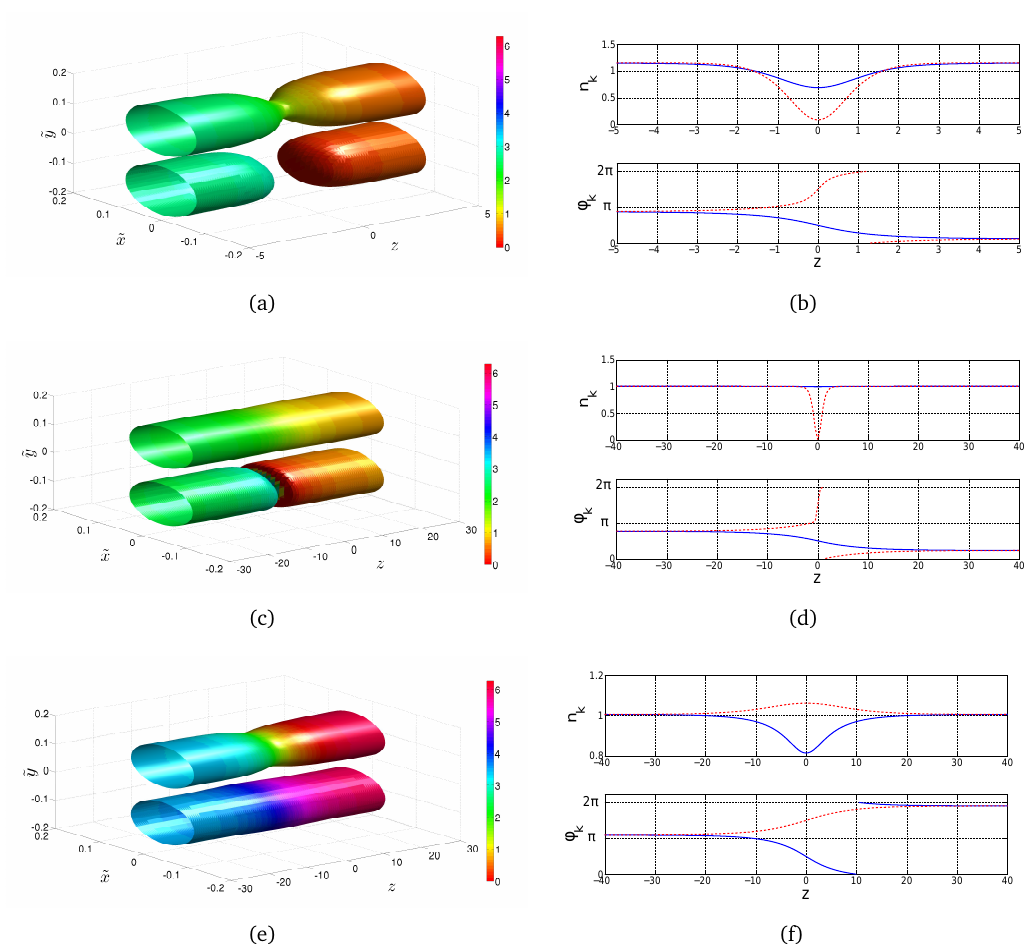
Figure 3: Numerical solutions from the Josephson vortex family corresponding to var- ious points of interest on the dispersion relations of Fig. 5. Left column: The density ( z ) = | ψ ( z ) | 2 is encoded in the width of the tube and the phase arg [ ψ ( z )] in the n k k k colour. The upper tube corresponds to component 1 and the lower one to component 2. ( z , ˜ x , ˜ y ) = n ( z ) exp [ − ( ˜ y ± 0.1 ) 2 + ˜ x 2 ] and plot isosurfaces at the value Specifically we define N k k 0.1 2 = 0.6. Right column: density (top panels) and phase (bottom panels) profiles are shown N k directly as a blue dashed line (component 1) and a red dashed line (component 2). (a) & = 1.34 π , (c) & (d) stationary Joseph- (b) Moving Josephson vortex: γ = 1, ν = 0.15, P c = 1.05 π , (e) & (f) moving Josephson vortex: son vortex maximum: γ = 1, ν = 0.005, P c γ = 1, ν = 0.005, P = 2.17 π c